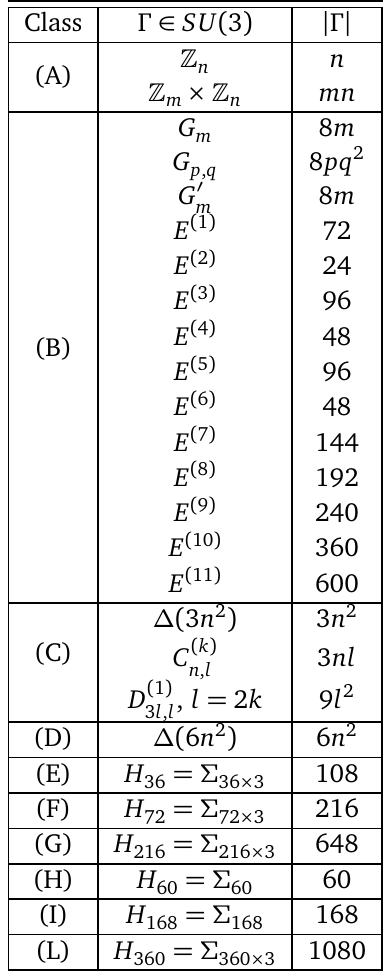
Table 1: Classification of finite subgroups Γ of SU ( 3 ) and the list of Γ used in this paper with their order | Γ |